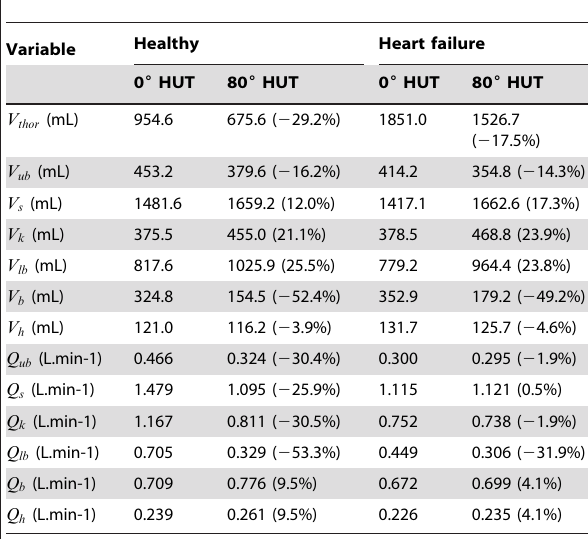
Table 4. Simulated regional blood flow and volume for both healthy and heart failure conditions during supine and 70 u